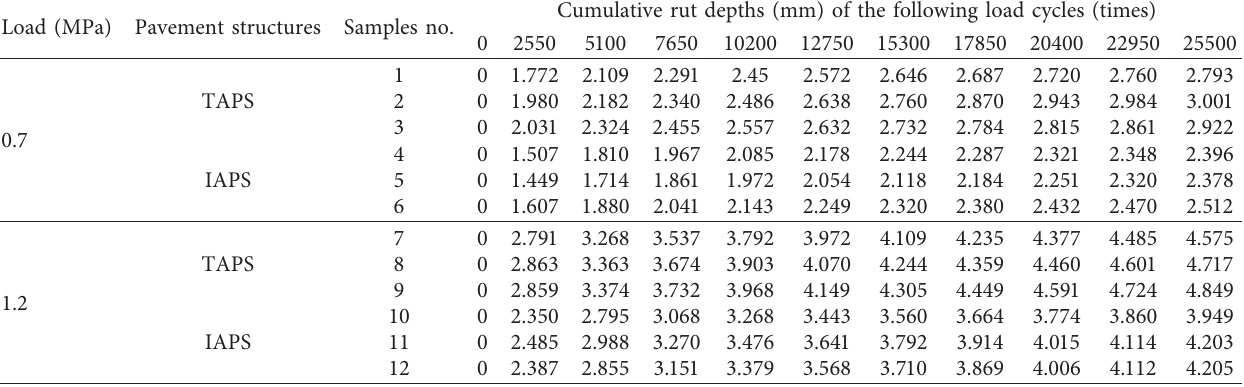
Table 8: Rutting test results of the slab specimens in different pavement structures. Load (MPa) Pavement structures Samples no.